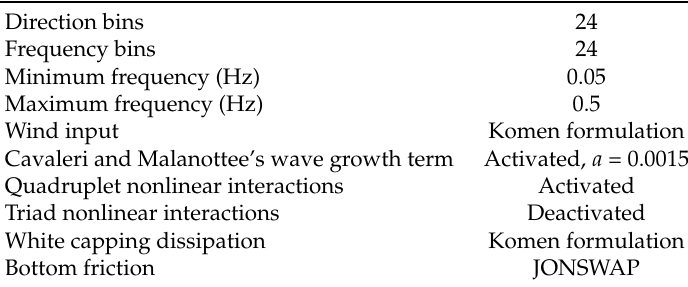
Table 3. Model parameters used for